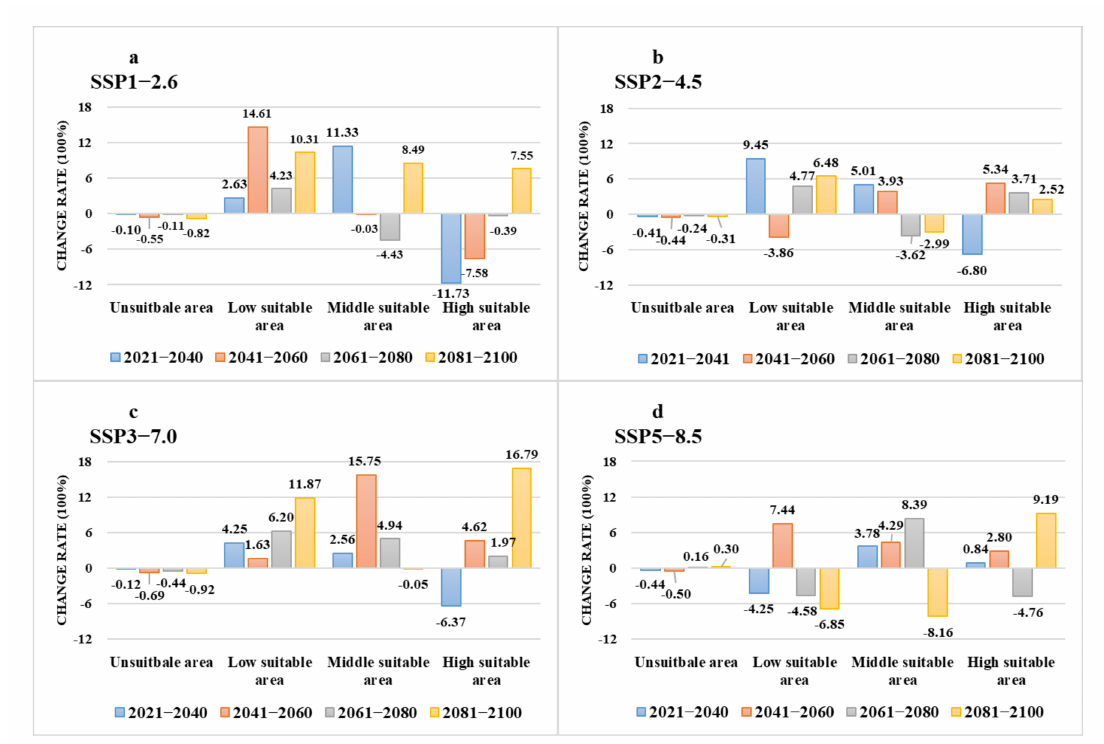
Figure 10. The change rate of future suitable areas as compared with current suitable areas and the four shared socio-economic pathways: ( a ) SSP1-2.6; ( b ) SSP2-4.5; ( c ) SSP3-7.0; ( d )